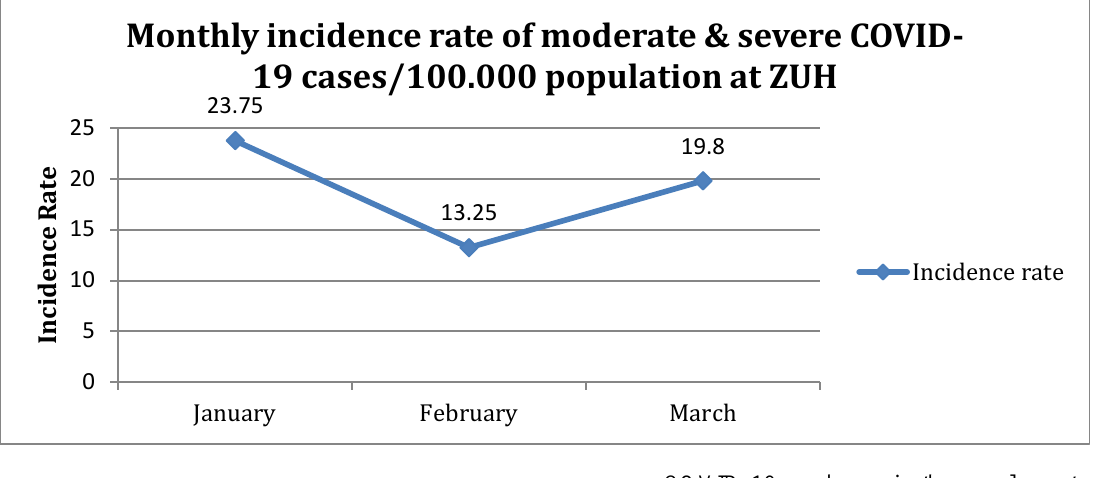
Figure 5. Monthly Incidence rate of moderate & severe COVID-19 cases at ZUH during the study